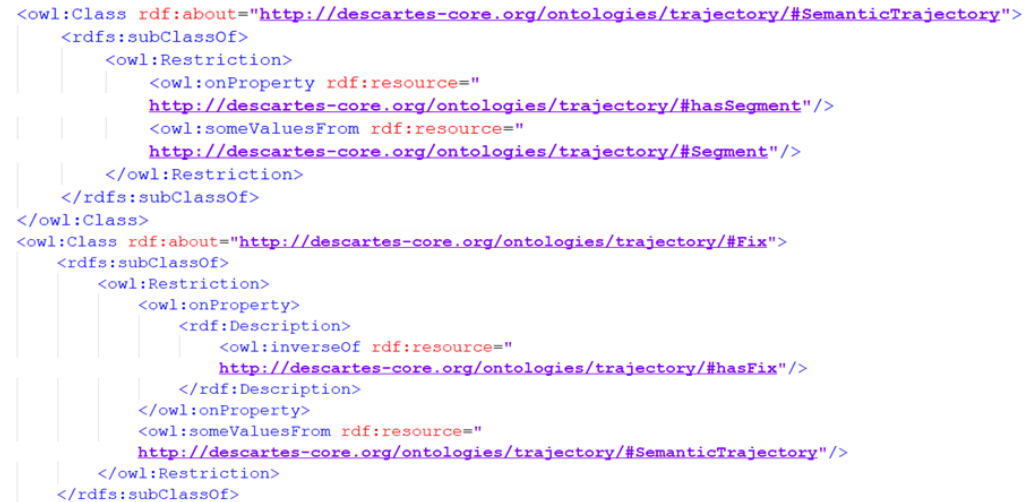
Figure 8. Definition of a semantic trajectory as a number of segments and fixes. Table 1. Ontologies used for the framework evaluation.